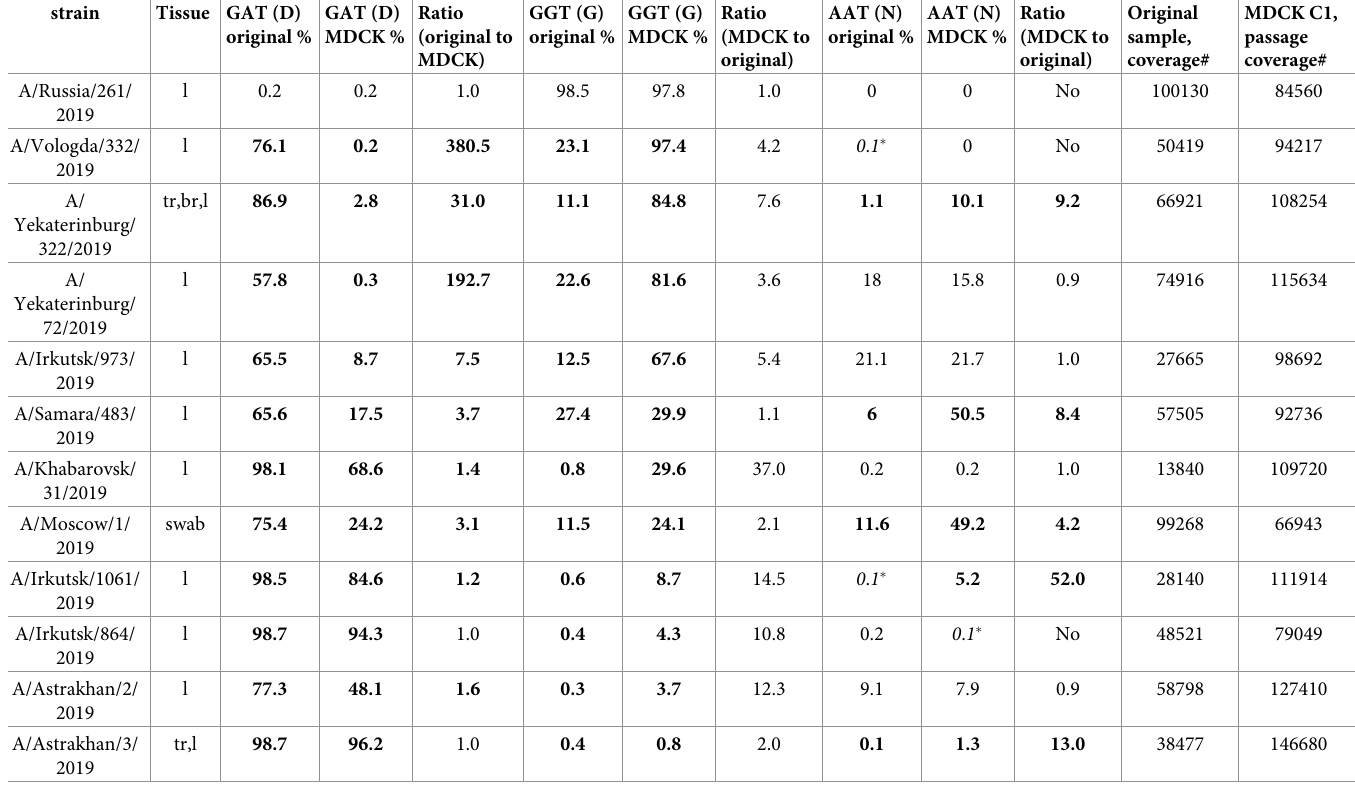
Table 4. Variation of the HA 222D/G/N polymorphism in the A(H1N1)pdm09 viruses in primary material (pm) and isolated on MDCK. strain